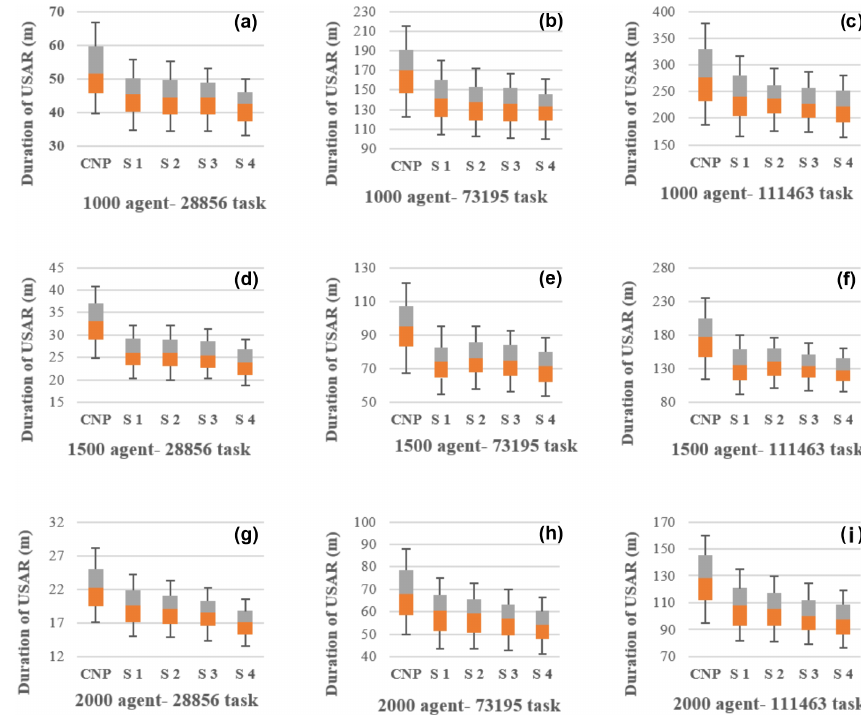
Figure 9. Uncertainty analysis of the proposed method for USAR operations, for nine simulated